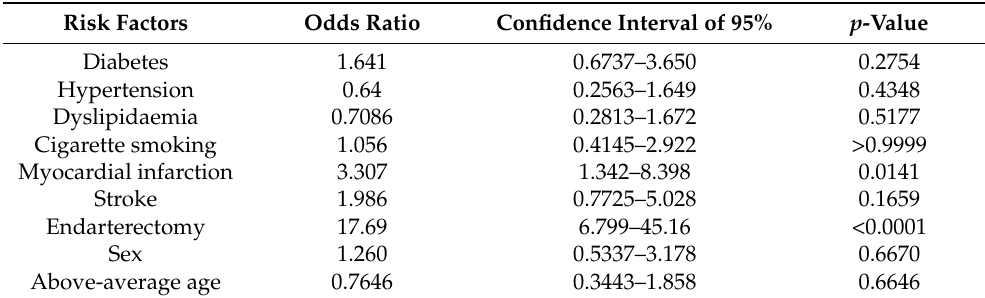
Table 5. Analysis of the correlations between the risk factors and worsening of carotid stenosis (worsened patients whose aggravation level is less than 70% vs. worsened patients whose aggravation level is more than